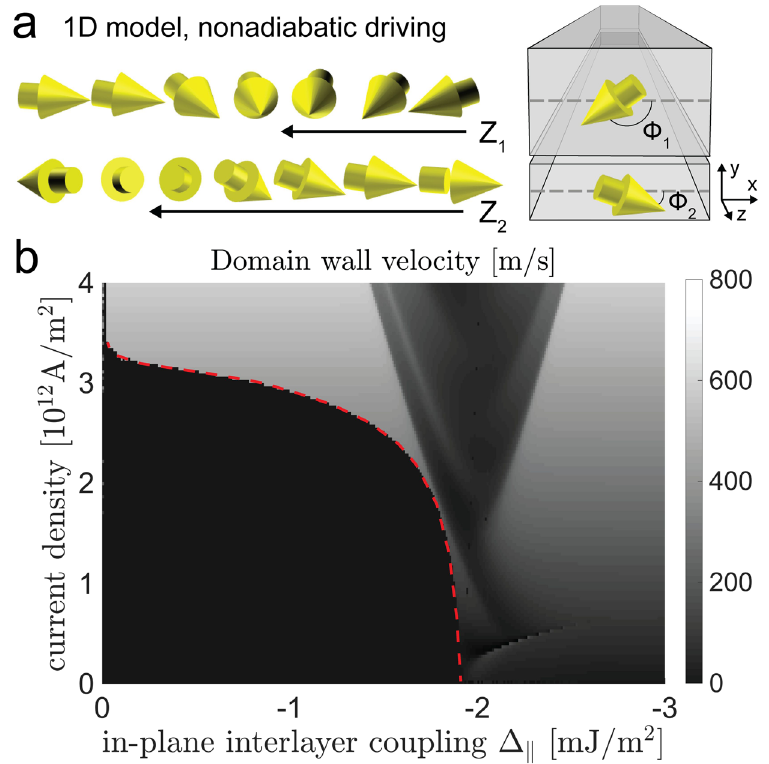
Figure 3. Nonadiabatic driving of anisotropically coupled DWs in a SyF nanowire. ( a ) Nonadiabatic driving pushes spins out of the wire plane in the direction where the perpendicular interlayer coupling is ferromagnetic. The angles of the spins with respect to the wire plane are denoted φ i , i = 1, 2, and the positions of the walls in the 1-D model are Z i , i = 1, 2. ( b ) DW velocity in the 1-D model as a function of in-plane interlayer coupling ∆ = − ∆ ⊥ (1/4) and driving current density, J , in the wire. The red dashed line indicates the threshold current for the DW motion. Walker breakdown occurs in the triangular region in the